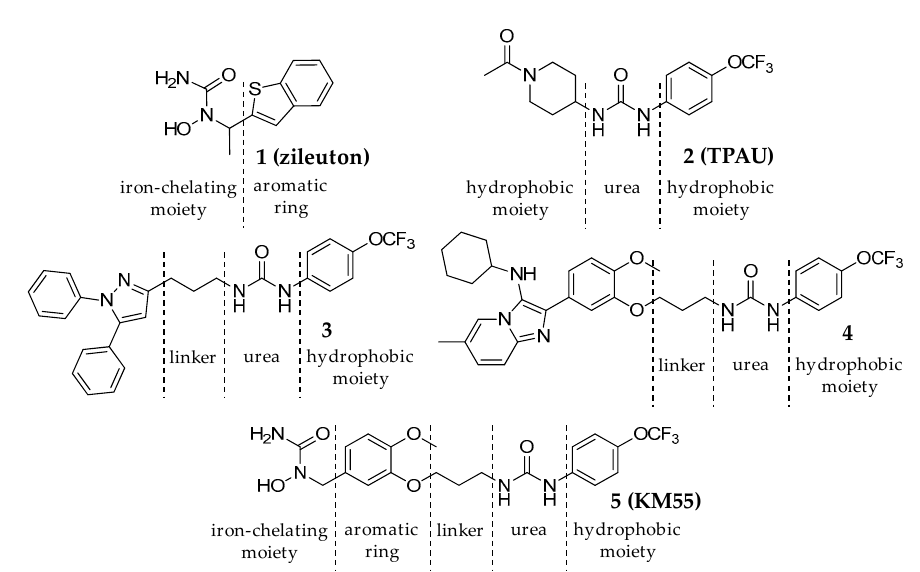
Scheme 1. Design strategy for a dual sEH/5-LOX inhibitor.